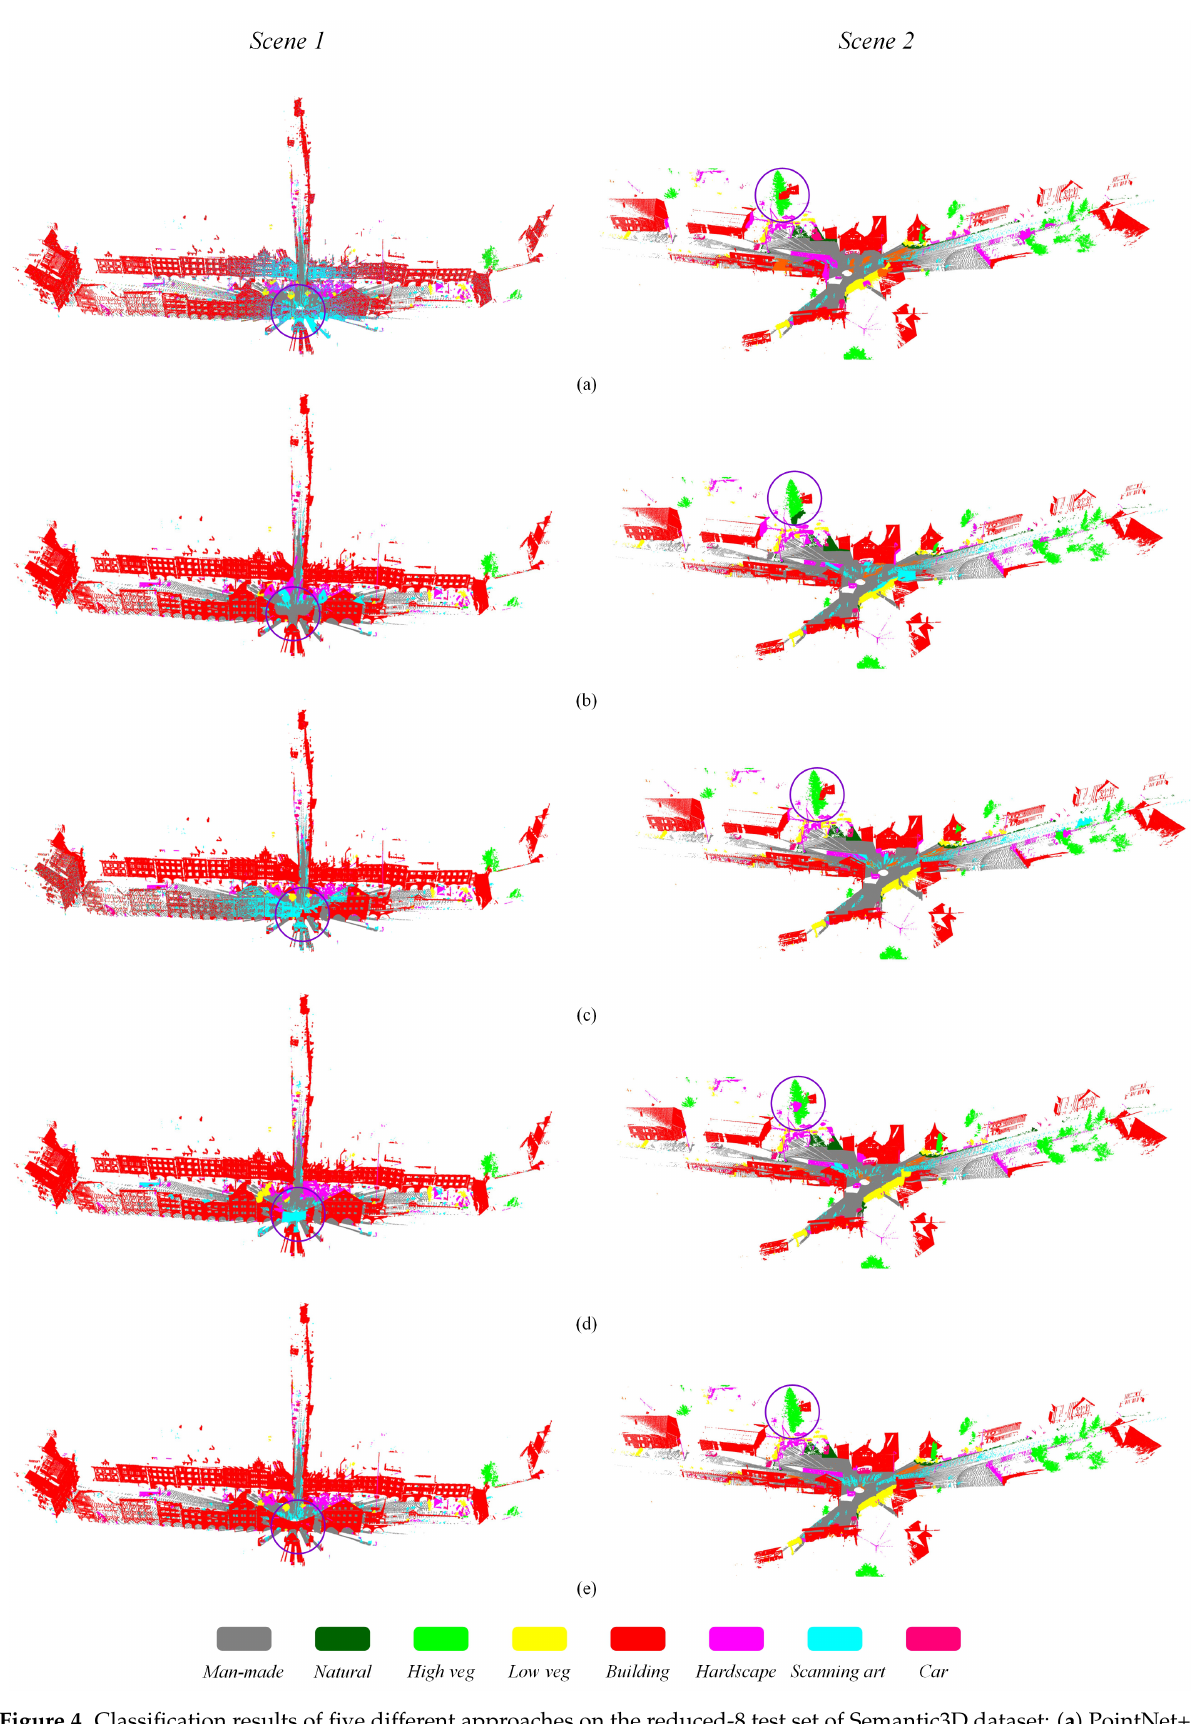
Figure 4. Classification results of five different approaches on the reduced-8 test set of Semantic3D dataset: ( a ) PointNet++ (MSG); ( b ) PointSIFT; ( c ) PointConv; ( d ) LSANet; ( e )